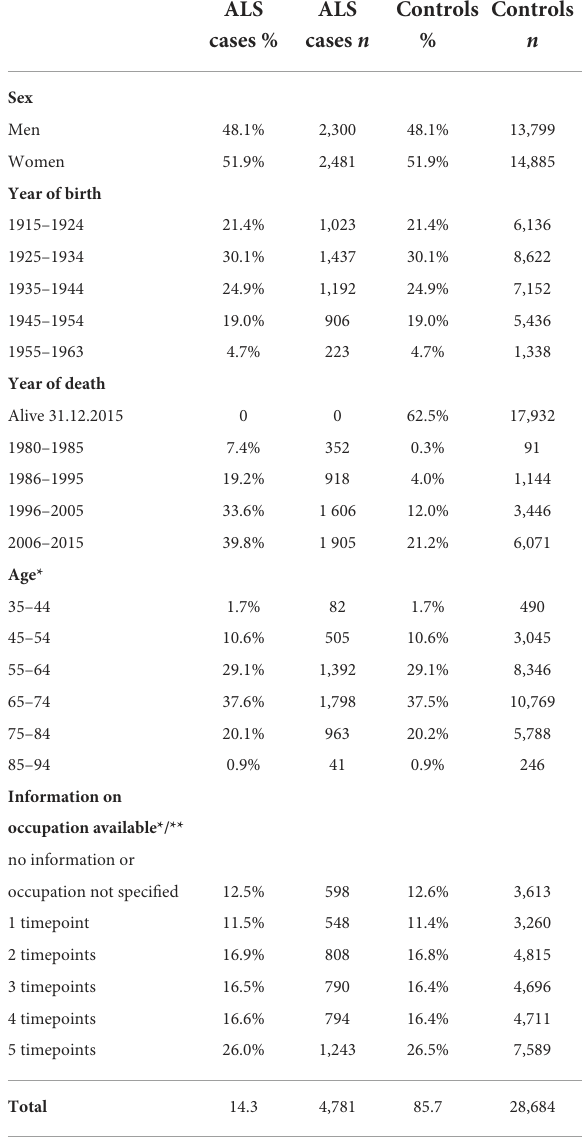
TABLE 1 Characteristics of ALS cases and